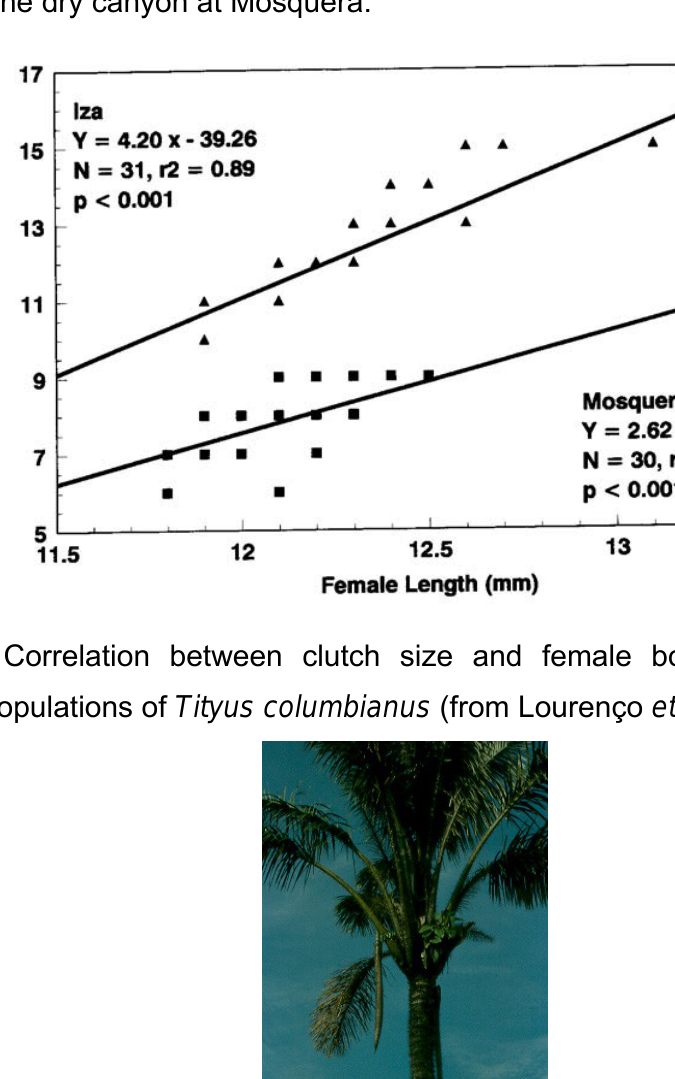
Figure 21. The dry canyon at Mosquera.